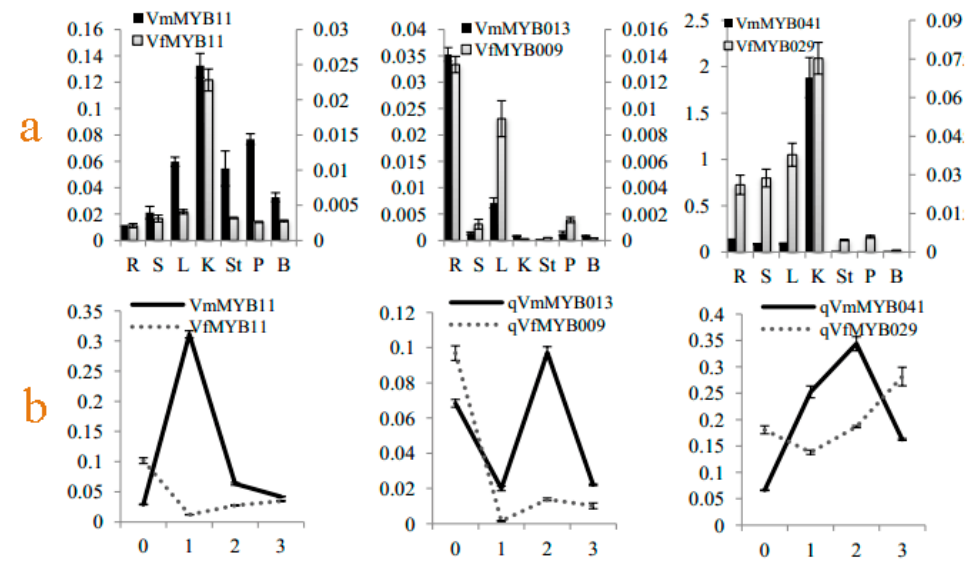
Figure 6. Tissue-specific expression analyses of three hub genes in Vernicia . The y-axis indicates the relative levels of expression. The left vertical axis indicates the expression levels of VmMYB ; the right vertical axis indicates the expression levels of VfMYB . The expression levels were analysed using RT-qPCR in triplicate. The x-axis indicates root (R), stem (S), leaf (L), kernel (K), stamen (St), petal (P) and bud (B) tissues used for the expression analysis ( a ). Root tissues of V. fordii and V. montana were used for the expression analysis responding to Fof-1 ( b ). The numbers in the x-axis represent the four stages of infection, as follows: 0, uninfected stage; 1, early stage of infection; 2, middle stage of infection; 3, late stage of infection.